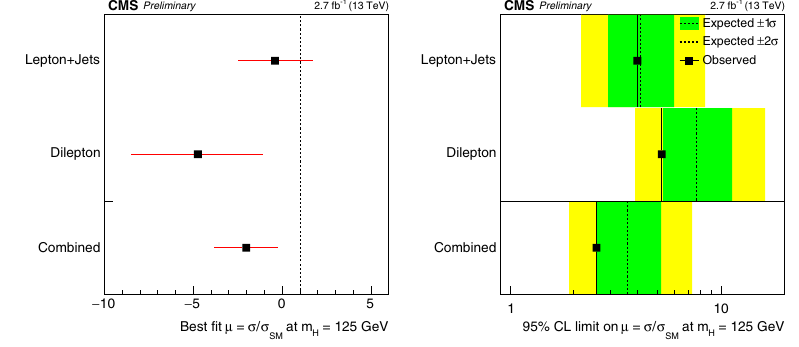
Figure 5. One of the final discriminant shapes, the 5 jets 3 b-tag category, in the lepton + jets channel before the fit to data [3]. The expected background contributions (filled histograms) are stacked, and the expected signal distribution (line) for a Higgs-boson mass of m H = 125GeV is superimposed. Each contribution is normalized to the integrated luminosity of 2 . 7fb − 1 , and the signal contribution is additionally scaled by a factor of 15 for better readability. The distribution in data (markers) is also shown.